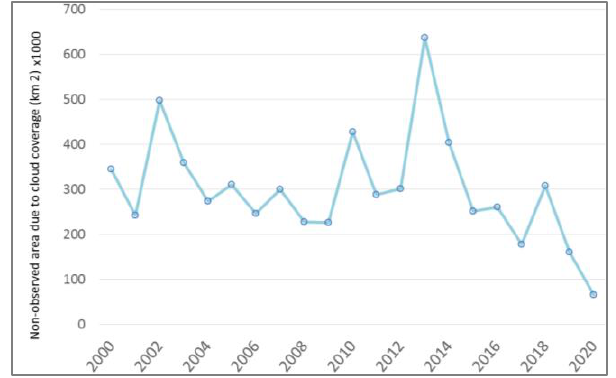
Figure 4 . Non-observed areas in km 2 (or areas under cloud cover) between 2000 and 2020* in PRODES annual